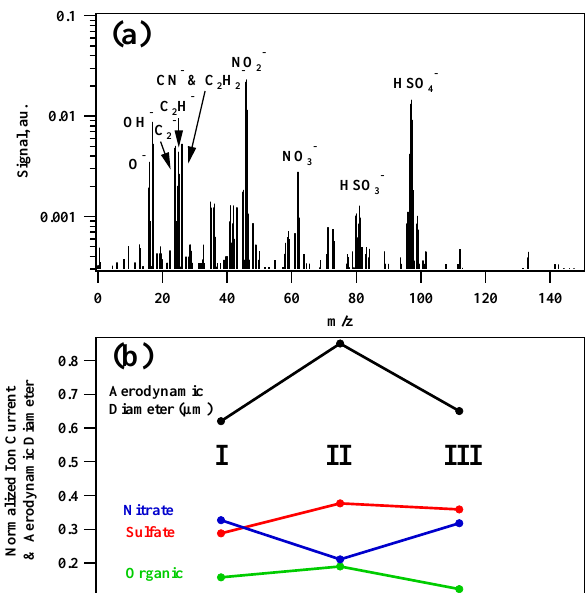
Fig. 8. Negative polarity mass spectrum of a CCN residual using the PALMS instrument (a) . Sulfate, nitrate and organic peaks are iden- tified. Time series averages of aerodynamic diameter and sulfate, nitrate and organic signal (b) . Period I is ambient data. Period II is from mass spectra after the CCNC and PCVI immediately after Period I. Period III is ambient data immediately after Period II. See text for